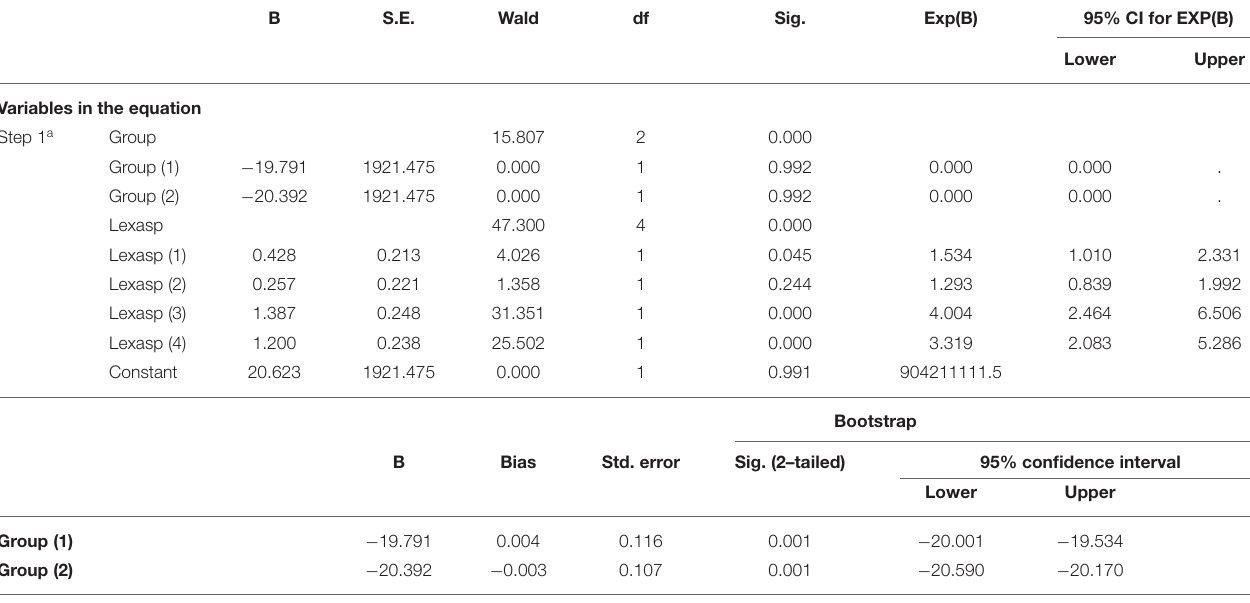
TABLE 7 | Outcome of logistic regression for the naming task. B S.E. Wald df Sig. Exp(B) 95% CI for EXP(B)